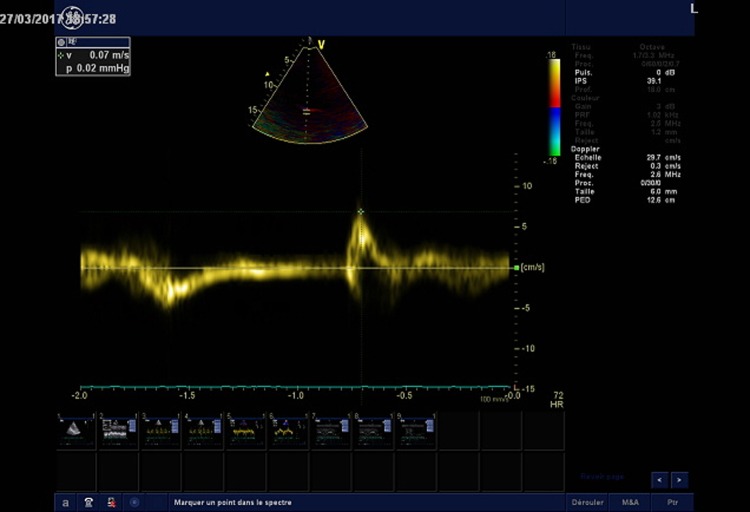
Pathological right hemidiaphragm peak tissue Doppler imaging velocity during a sniff maneuver in a DMD patient.Note the reduced peak sniff diaphragm TDI velocity (arrow).